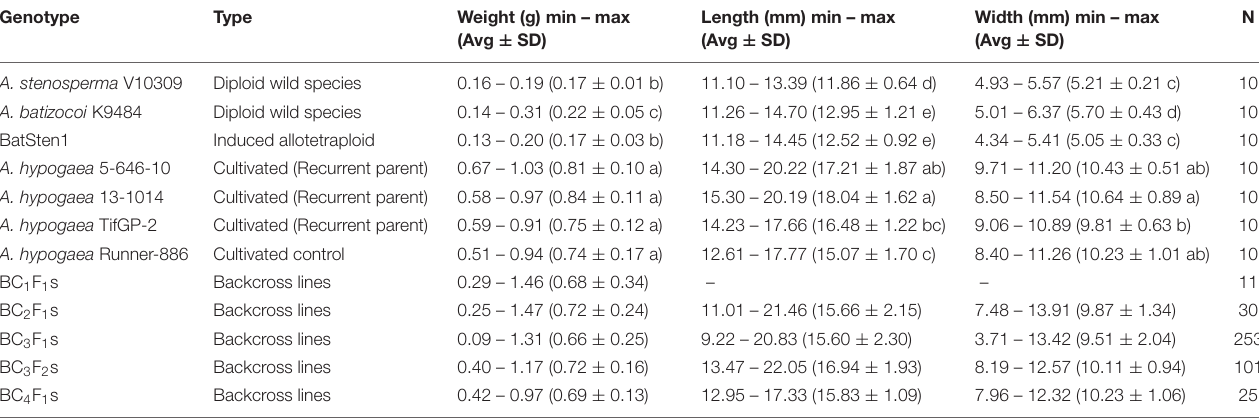
TABLE 2 | Average and standard deviation for seed weight, length, and width measured in BC n F n lines, diploid wild species, induced allotetraploid BatSten1, and cultivated